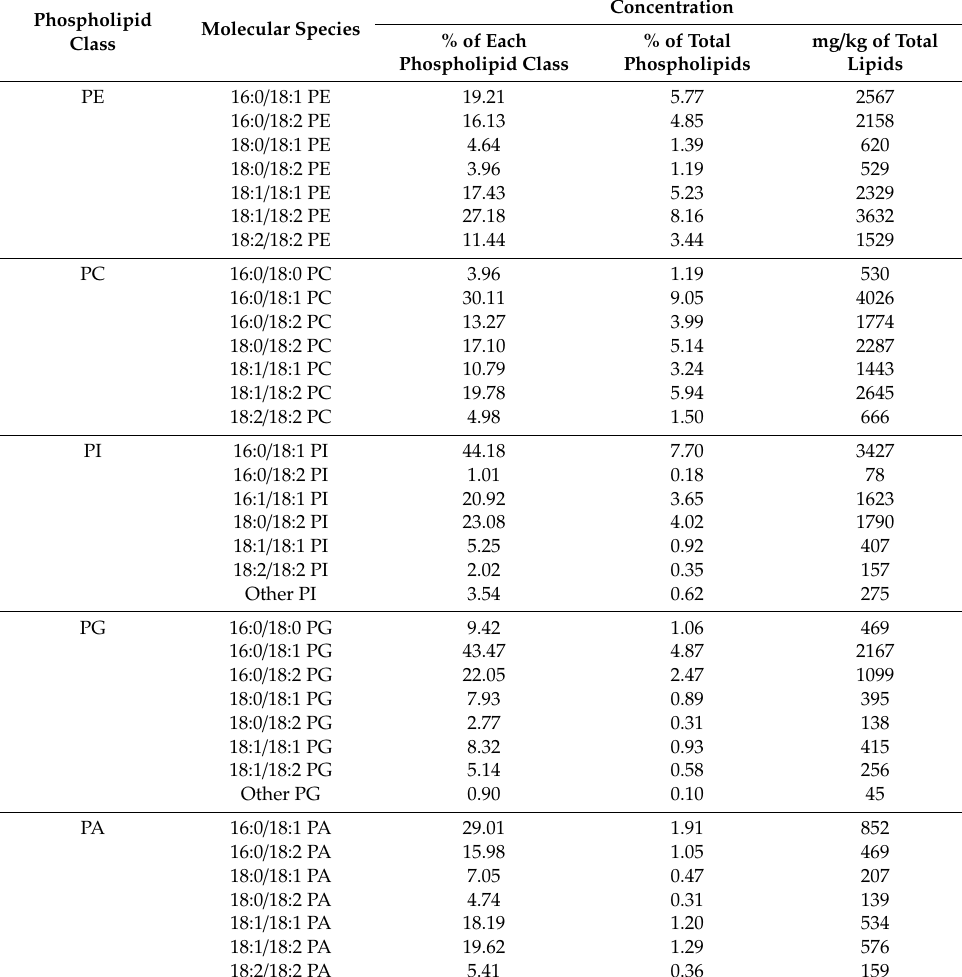
Table 8. Content of molecular species of phospholipids obtained from Madhuca ellitica seeds. Phospholipid Molecular Species Class